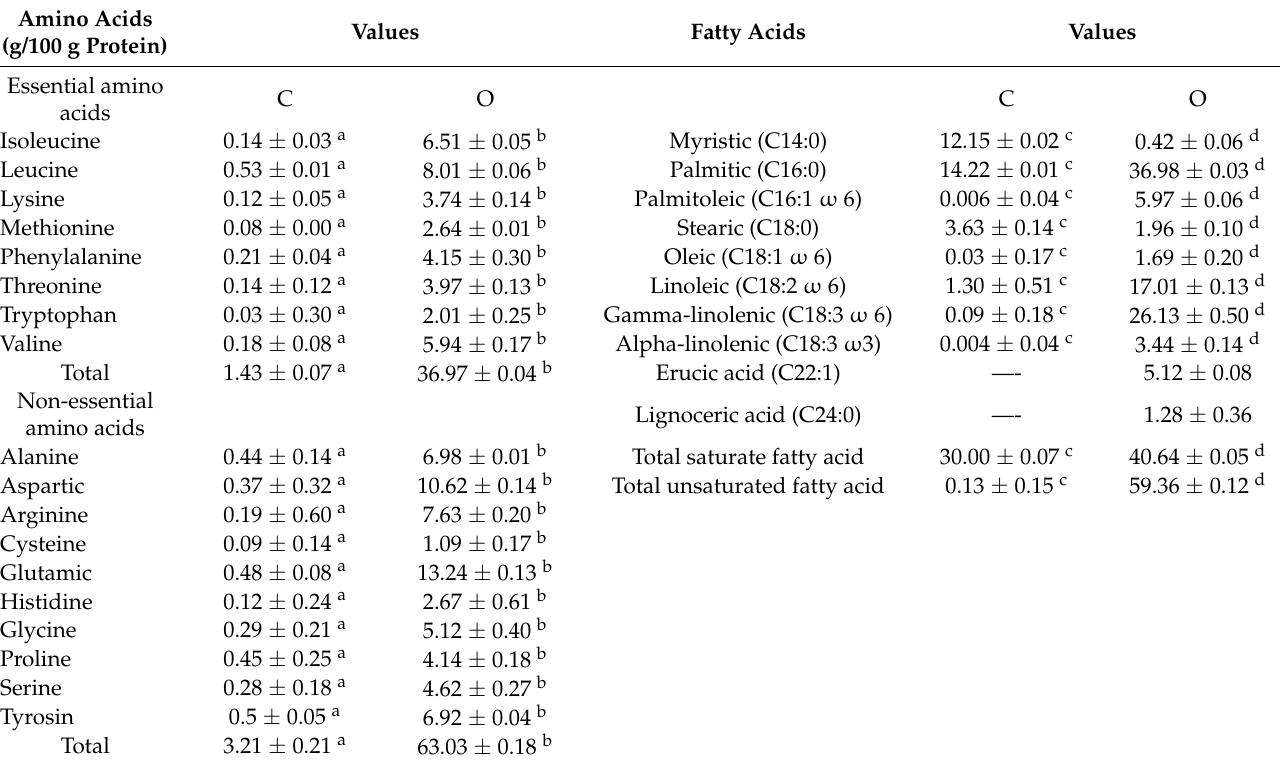
Table 6. Fatty acid and amino acid profiles of the sample of control (C) and optimal snacks (O).